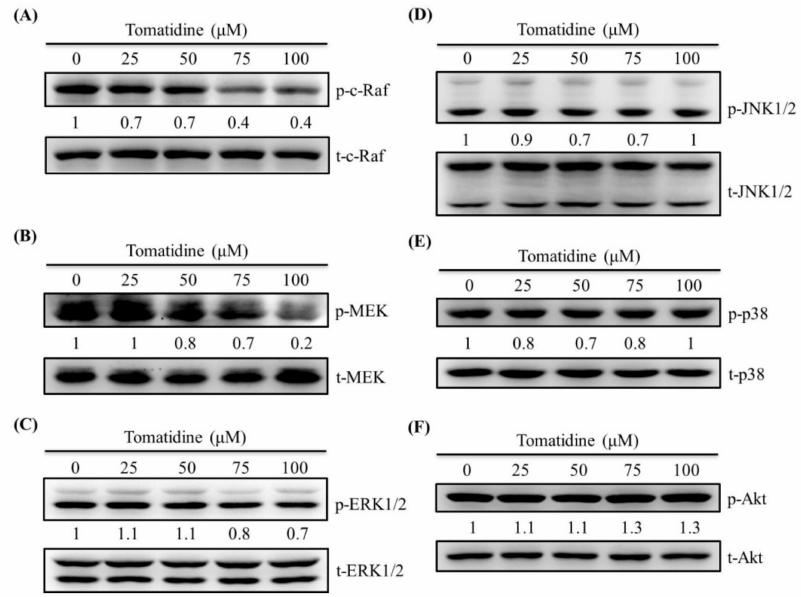
E ff ects of tomatidine on Raf, mitogen / extracellular signal-regulated kinase (MEK), mitogen-activated protein kinases (MAPKs), and phosphatidylinositide-3 kinase-Akt (PI3K-Akt) in U2OS cells. Western blot analyses for total or phosphorylated forms of ( A ) Raf, ( B ) MEK, ( C ) ERK 1 / 2, ( D ) JNK 1 / 2, ( E ) p38, and ( F ) Akt after various concentrations (0, 25, 50, 75, and 100 µ M) of tomatidine treatment for 24 h in U2OS cells were measured as described in the Materials and Methods section